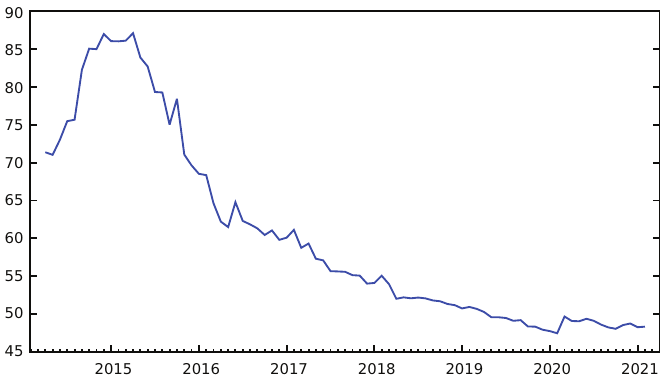
Figure 2. The total connectedness